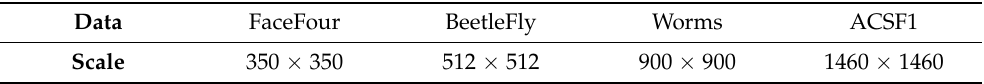
Figure 11. The ablation experiment results. The horizontal axis is the parameter L UB , the vertical axis is the memory cost running on different data. *-P and *-NP stand for the method with and without pruning, respectively. Table 3. The scales of the data shown in Figure